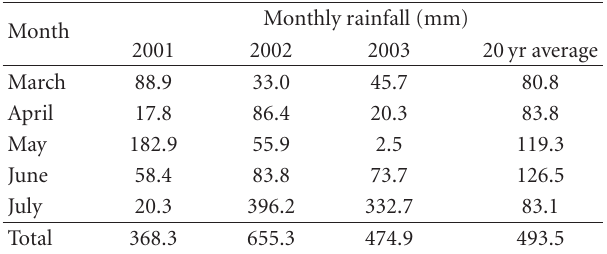
Table 1: Monthly rainfall at the study location from 2001 to